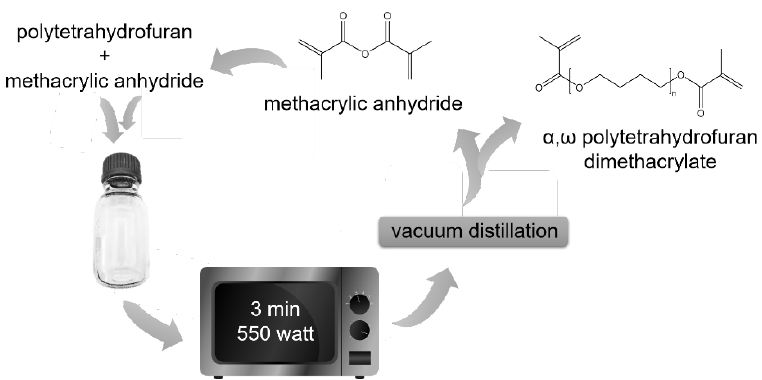
Figure 3. Microwave-induced transesterification of PTHF 2900 with methacrylic anhydride followed by vacuum distillation, separating the highly temperature stable PTHF 2900 -DM from recyclable methacrylic anhydride and methacrylic acid.